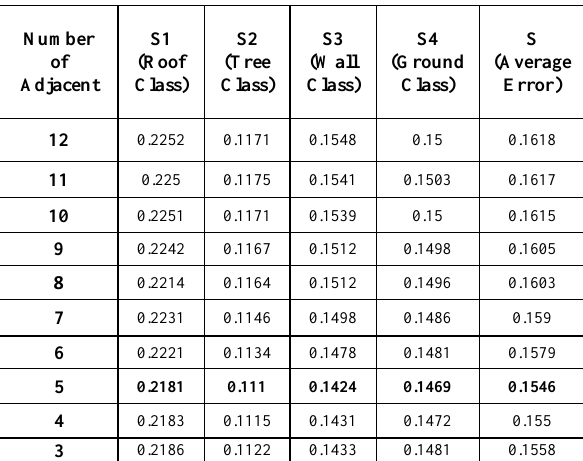
Figure 5 . The results of segmentation method.